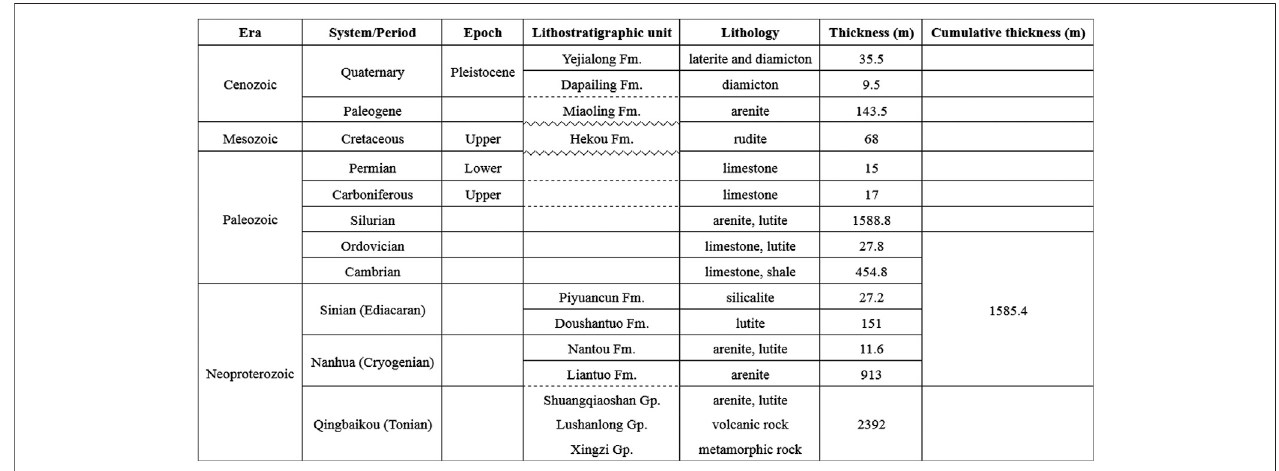
FIGURE 3 | Stratigraphic column of sedimentary and metamorphic units of Lu Mountain (according to the 1:50,000 geological maps and the auxiliary instructions produced by the Jiangxi Bureau of Geology and Mineral Resources in 1993 and